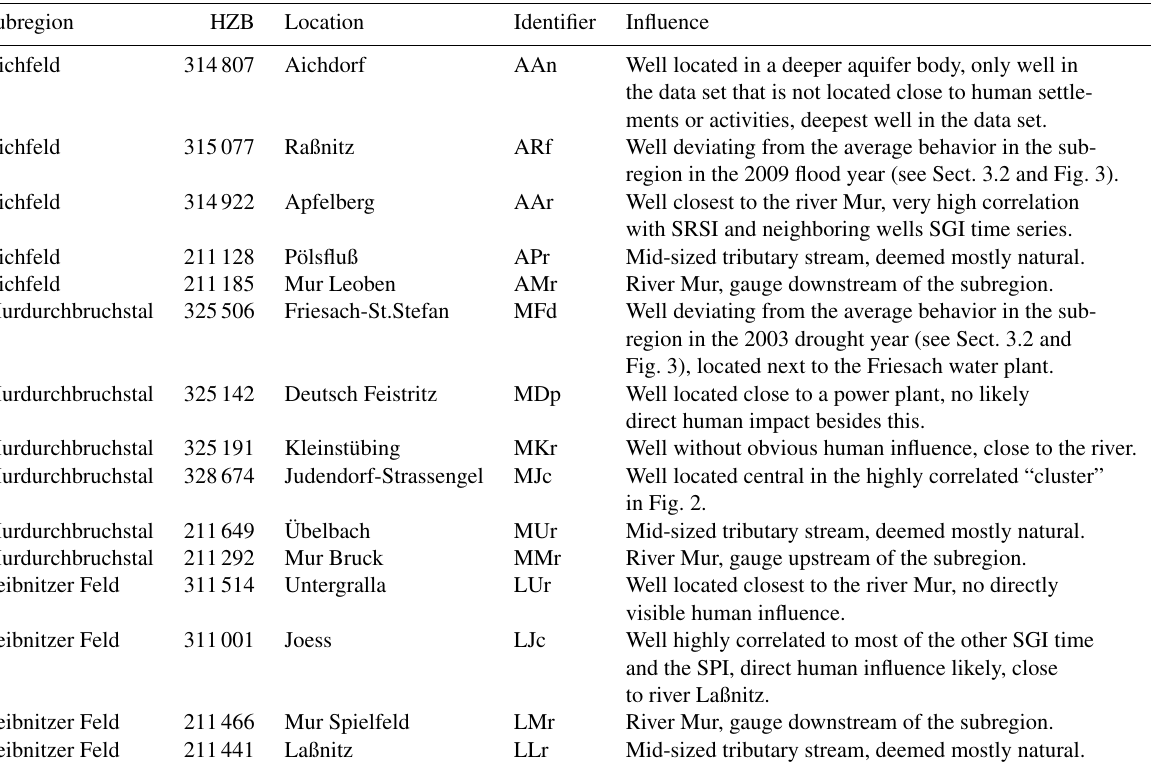
Table 1. Wells selected for closer investigation or specifically mentioned in the text. The “HZB” (from Hydrographisches Zentralbüro) refers to their identifier at the ehyd.gv.at website. The “Identifier” is a short code used in this paper to identify the wells in the various plots. “Influence” lists factors that might affect the behavior of the groundwater shown in the